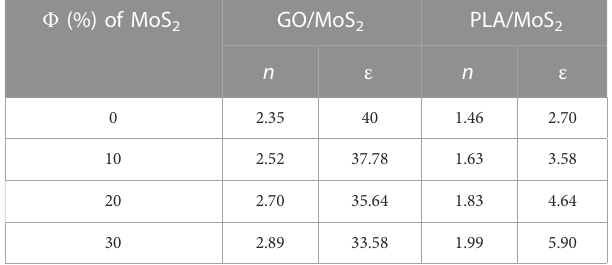
TABLE 3 Refractive index “ n ” and dielectric constant “ ε ” of nanocomposites GO/MoS 2 and PLA/MoS 2 as a function of the volume fraction ( Φ ) of MoS 2